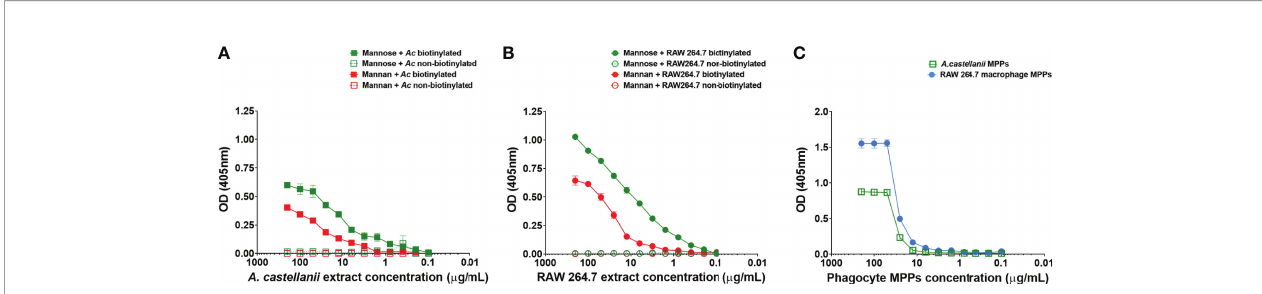
FIGURE 2 | Acanthamoeba castellanii and macrophage extracts showed a dose-dependent binding to mannose and mannan. Indirect ELISA demonstrated dose dependent binding of clari fi ed extracts of (A) A. castellanii (Ac) and (B) RAW 264.7 macrophages to mannan and mannose. (C) MPPs of Ac and macrophages displayed a more intense binding to mannose than the phagocyte ’ s biotinylated surface extracts. In addition, MPPs of macrophages seem to bind more effectively to mannose in comparison to Ac MPPs. The streptavidin-alkaline phosphatase conjugate was used to detect biotinylated proteins. As a negative control, clari fi ed non- biotinylated extracts were used in the process and displayed no